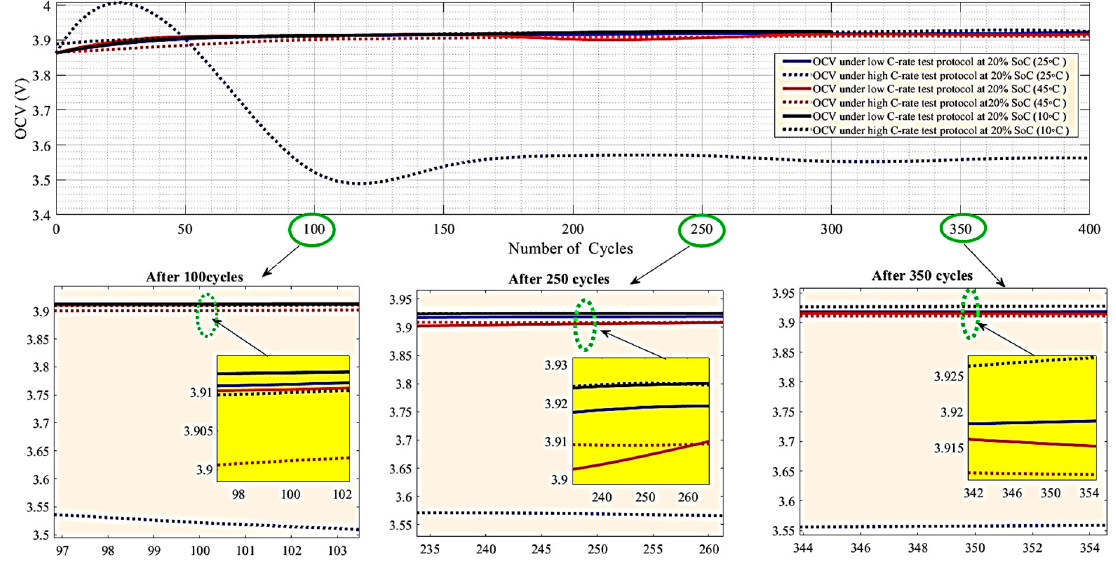
Figure 17. Behavior of OCV at 10 °C, 25 °C, and 45 °C under high and low discharge tests during the lifetime of the battery at 20% SoC.